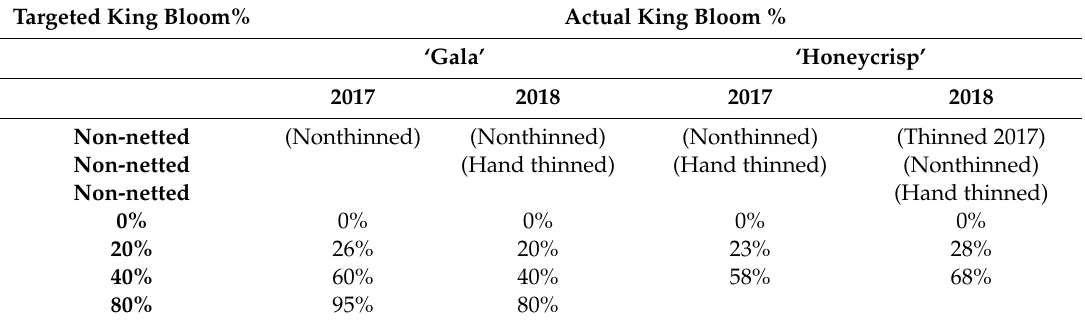
Table 1. Net enclosure treatments for ‘Gala’ and ‘Honeycrisp’ experiments in 2017 and 2018. Data are percent of open king bloom at time nets were fully closed around multitree